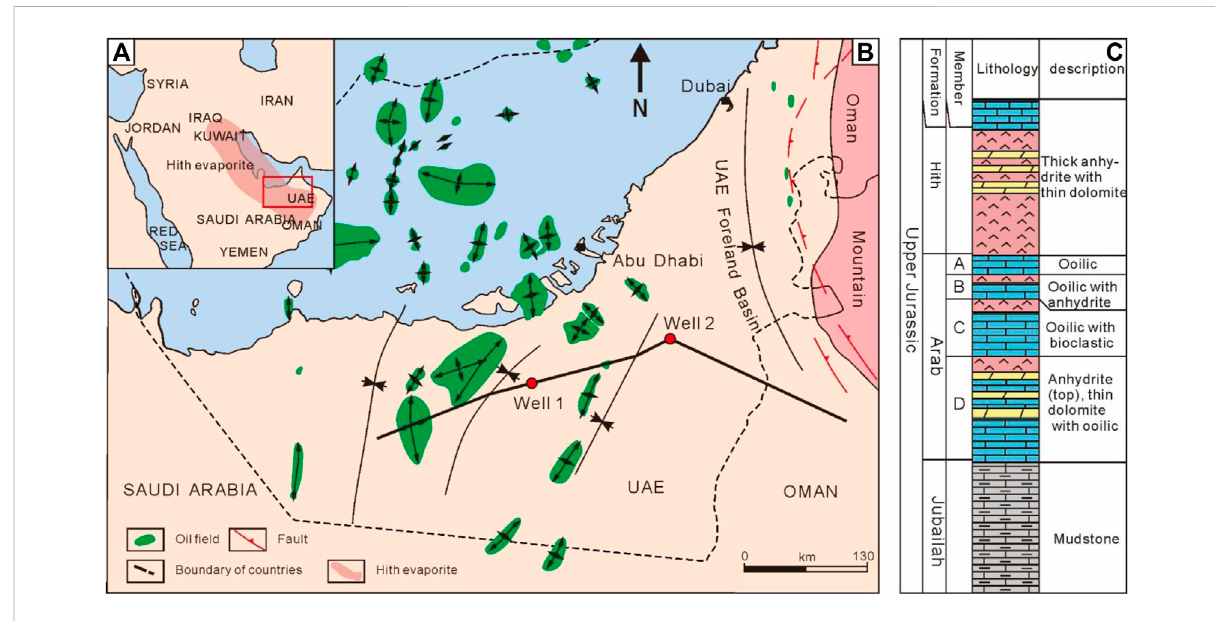
FIGURE 13 The location of the research area (A) the distribution of Hith evaporite comes from (Al-Husseini, 1997); The detail of the research area (B) The comprehensive stratigraphic histogram of the upper Jurassic in the western UAE (C) modi fi ed from (Al-Husseini, 1997; Ali and Farid, 2016)